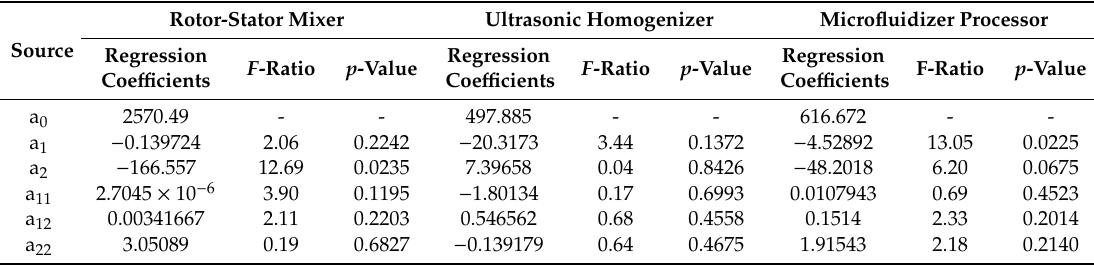
Table 4. Analysis of variance of the regression coefficients of the quadratic Equation (3) for the W/O/W emulsion preparation by three high-energy emulsification methods.